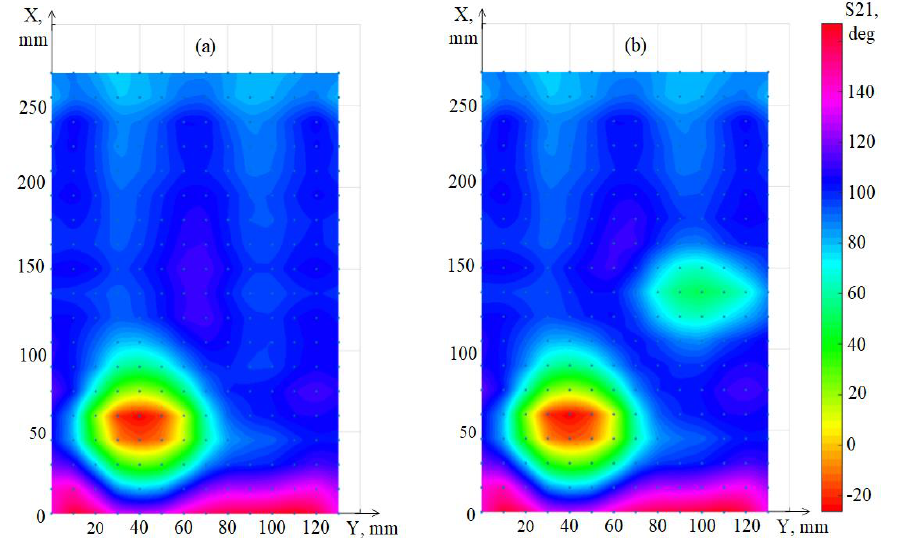
Fig. 4. Simulation results of the phase of the transmission coefficient estimation with a 900 MHz signal without heterogeneity (a) and with heterogeneity